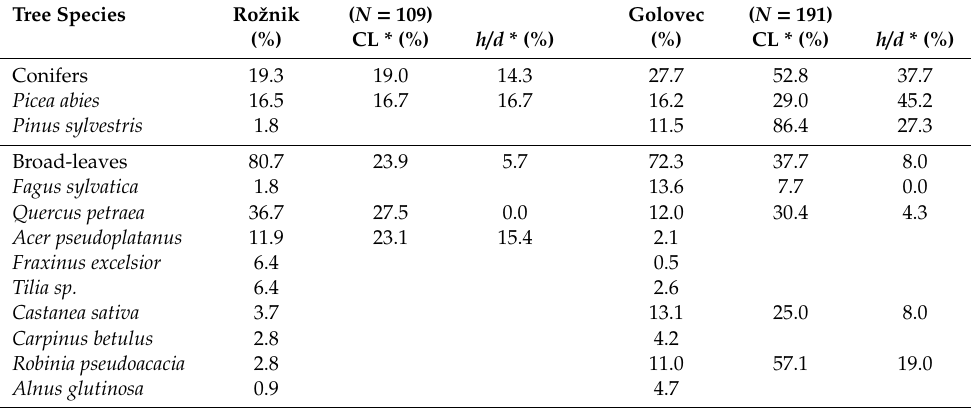
Table 3. The shares of the dominant tree species in a sample at the forest edges of Rožnik and Golovec, in the year 2019. The share of the trees with a crown shorter than half of the total tree length (CL) and the share of the trees with an unfavorable h/d dimension ratio for coniferous trees (>65) and deciduous trees (>80).